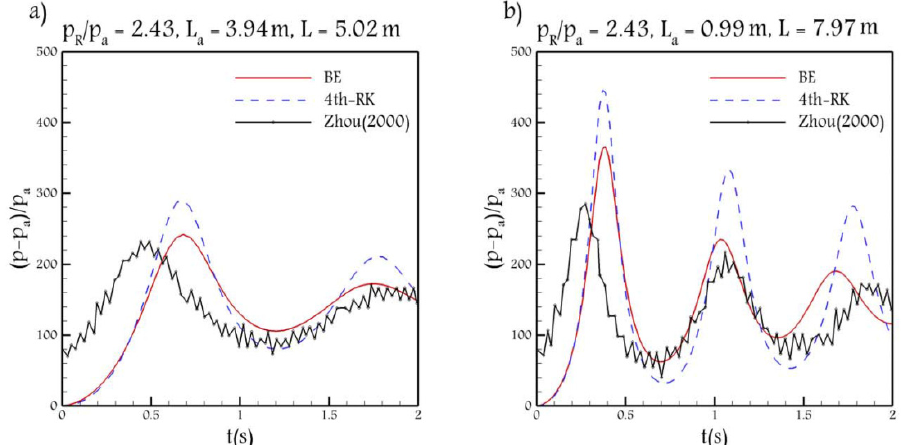
Figure 5. The non-dimensional air absolute pressure (p p (cid:2911) ⁄ ) distribution vs. the time, calculated by both backward Euler scheme, and classical 4th order Runge–Kutta scheme, for a test case of Zhou [20], p (cid:2902) p (cid:2911) ⁄ = 2.43 and ( a ) λ = 0.56 , and ( b ) λ = 0.89 .